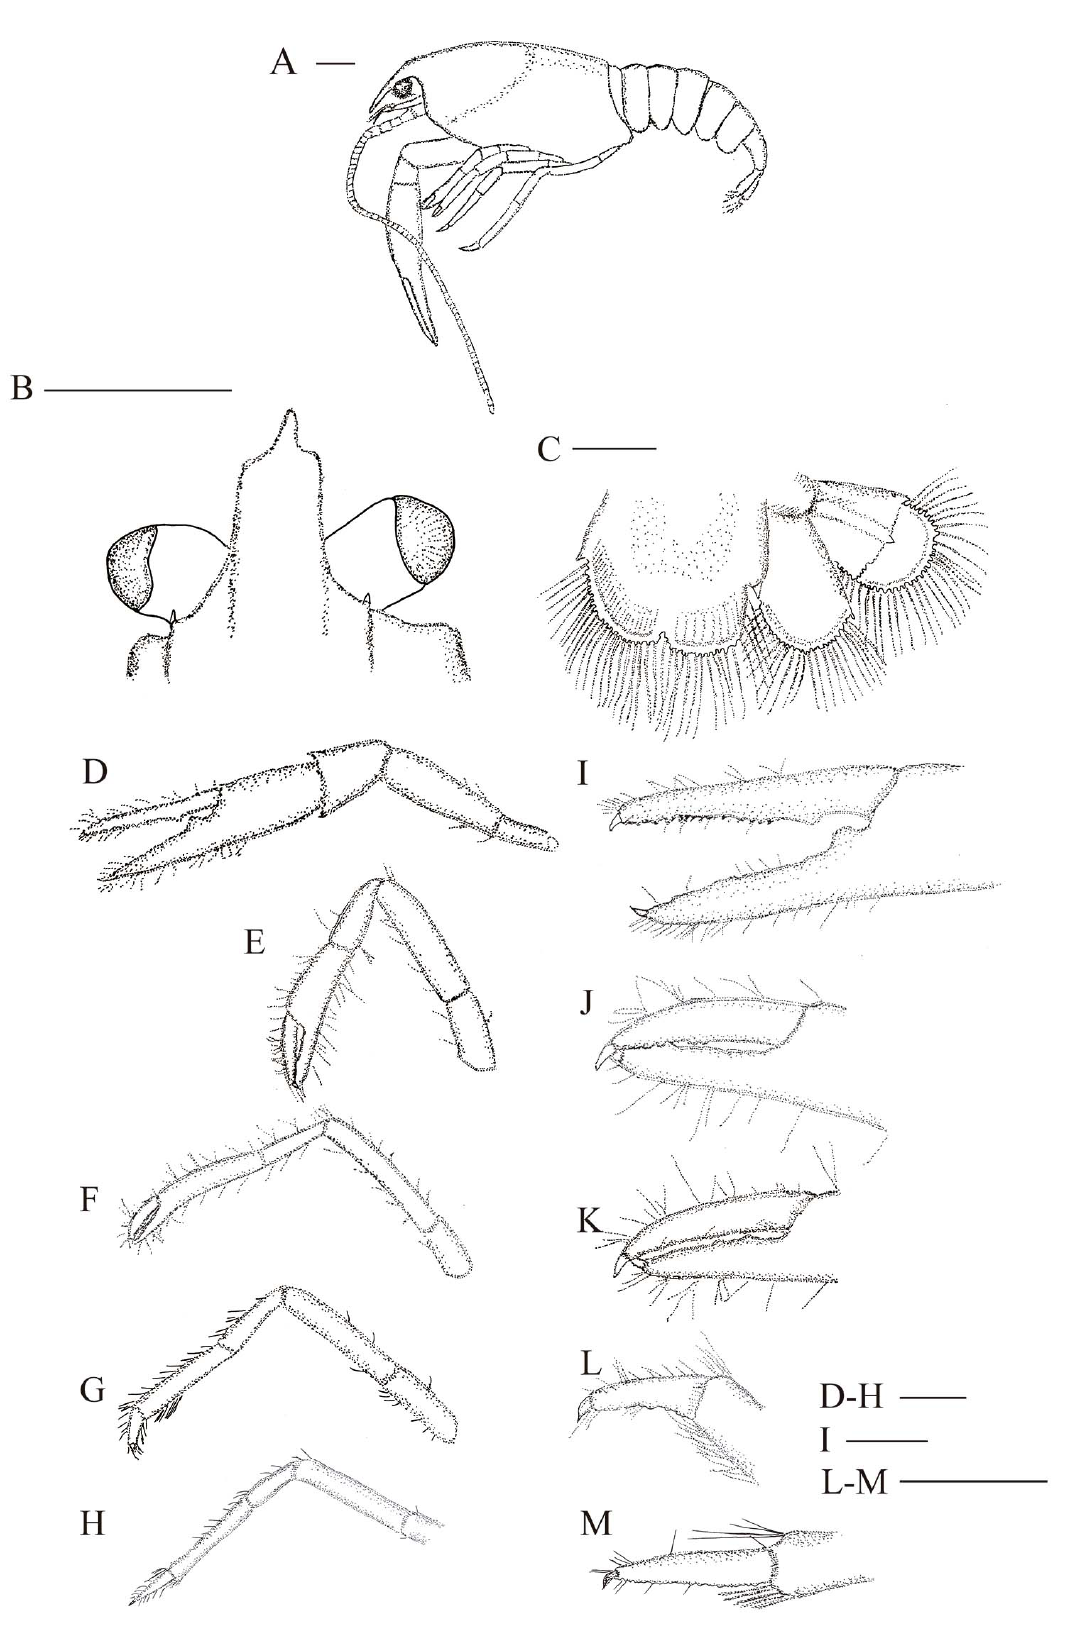
Figure 5. Juvenile Stage III of Austropotamobius torrentium . ( A ) Habitus, lateral view; ( B ) eyes and rostrum, dorsal view; ( C ) tail fan, dorsal view; ( D–H ), pereiopods 1–5, dorsal or lateral view; ( I–M ) distal segments of pereiopods 1–5, dorsal or lateral view. Scale bars: 0.25